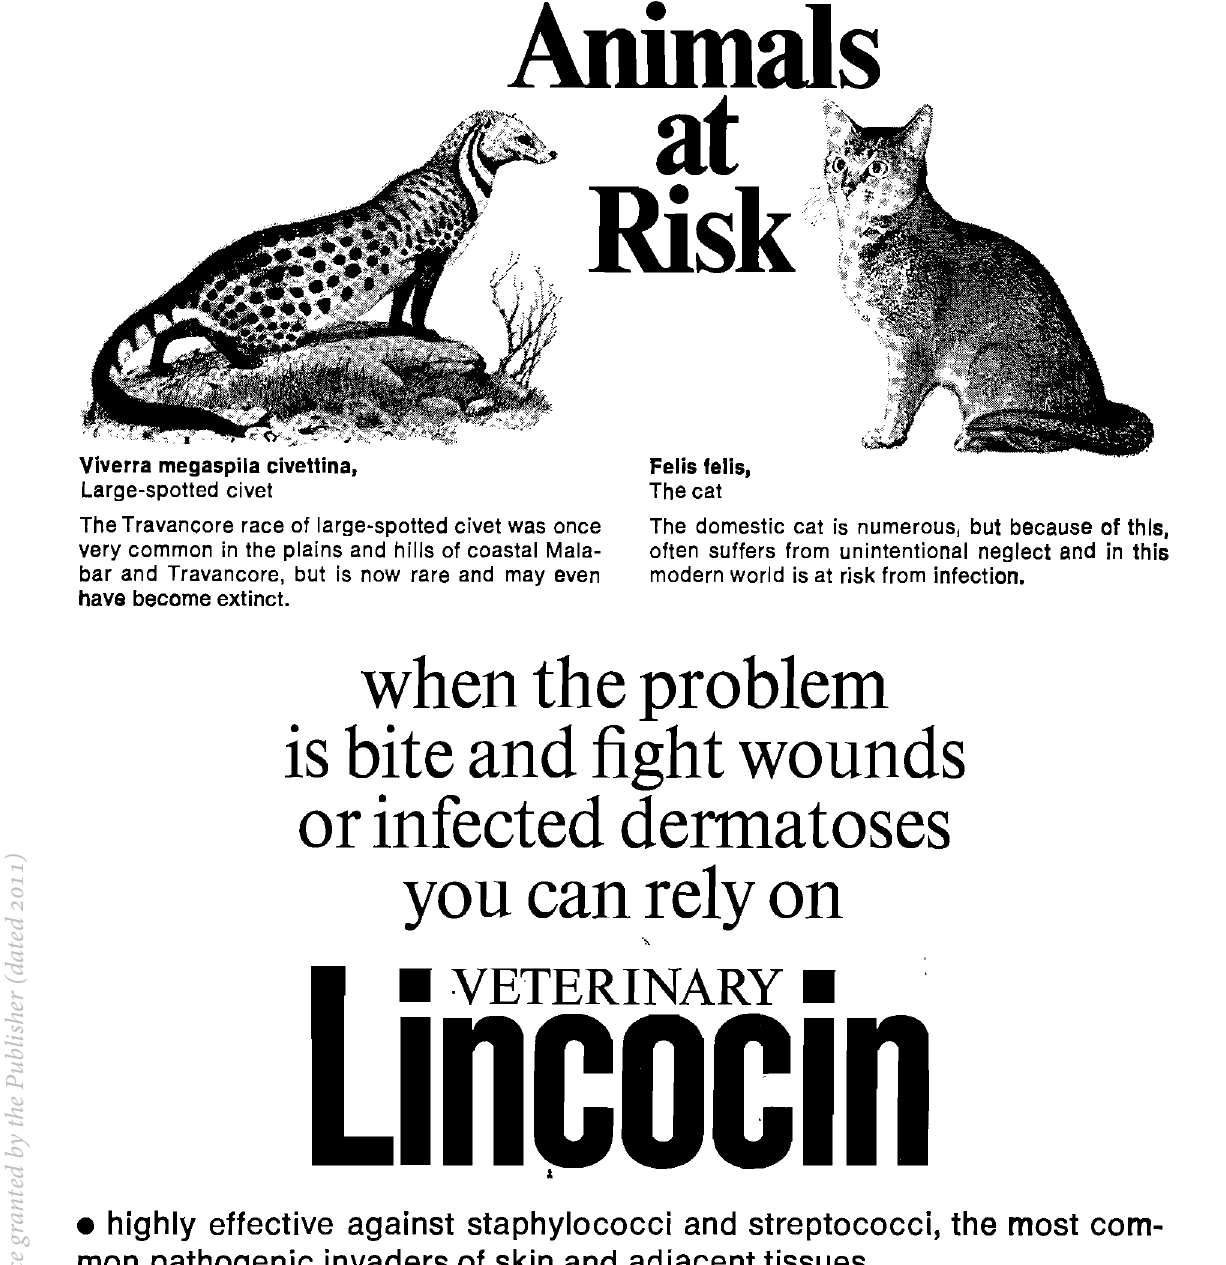
Viverra megaspila eivettina. Large-spotted civet